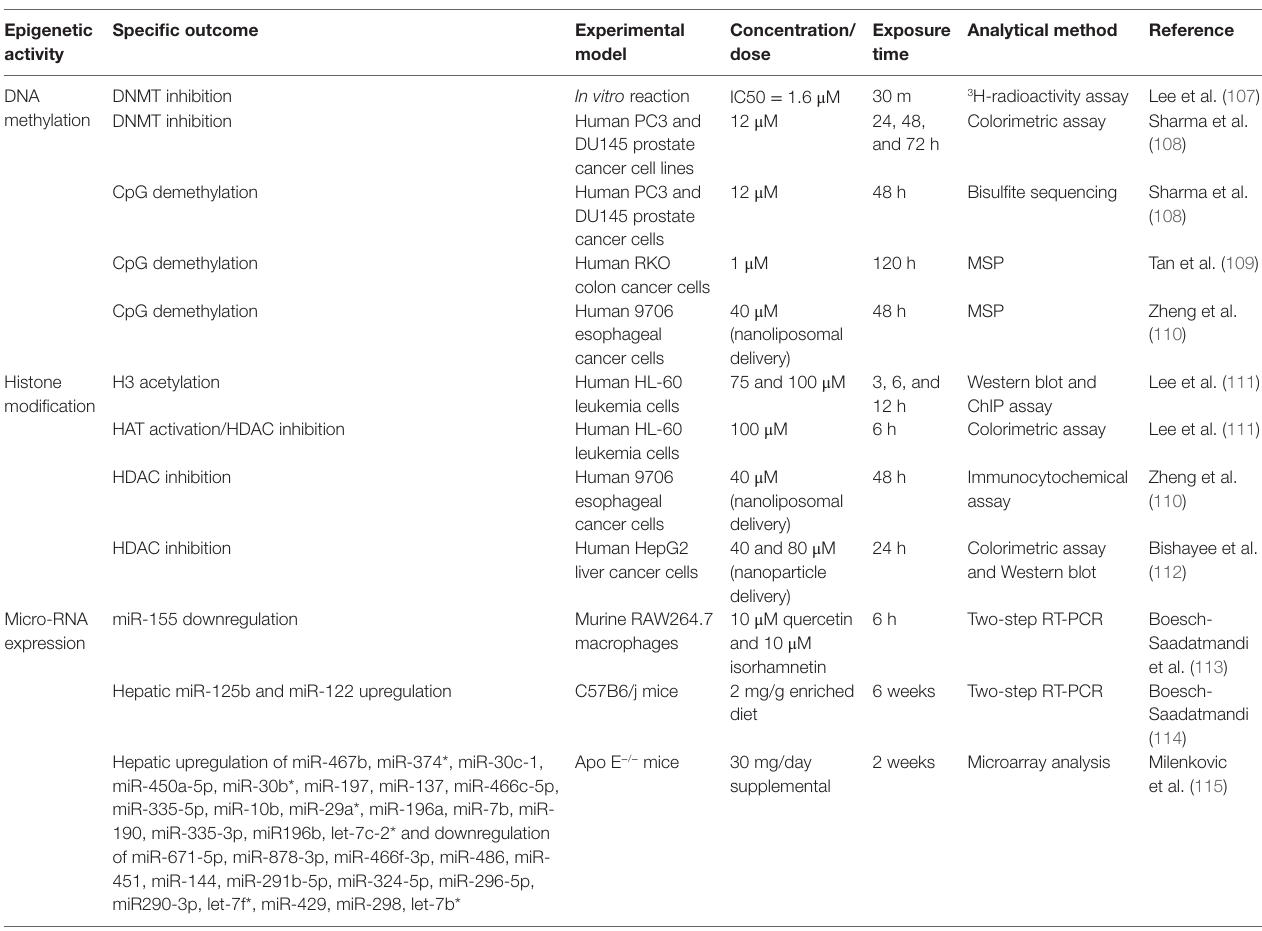
TAbLe 2 | epigenetic activity elicited by quercetin. epigenetic